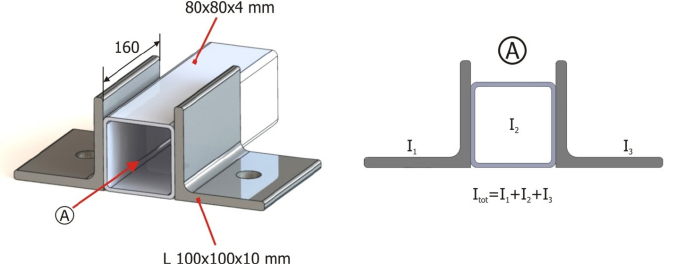
Figure 11. Characteristics of the structure and calculation of the moment of inertia equivalent to the cross-section in the regions of the clamping devices.